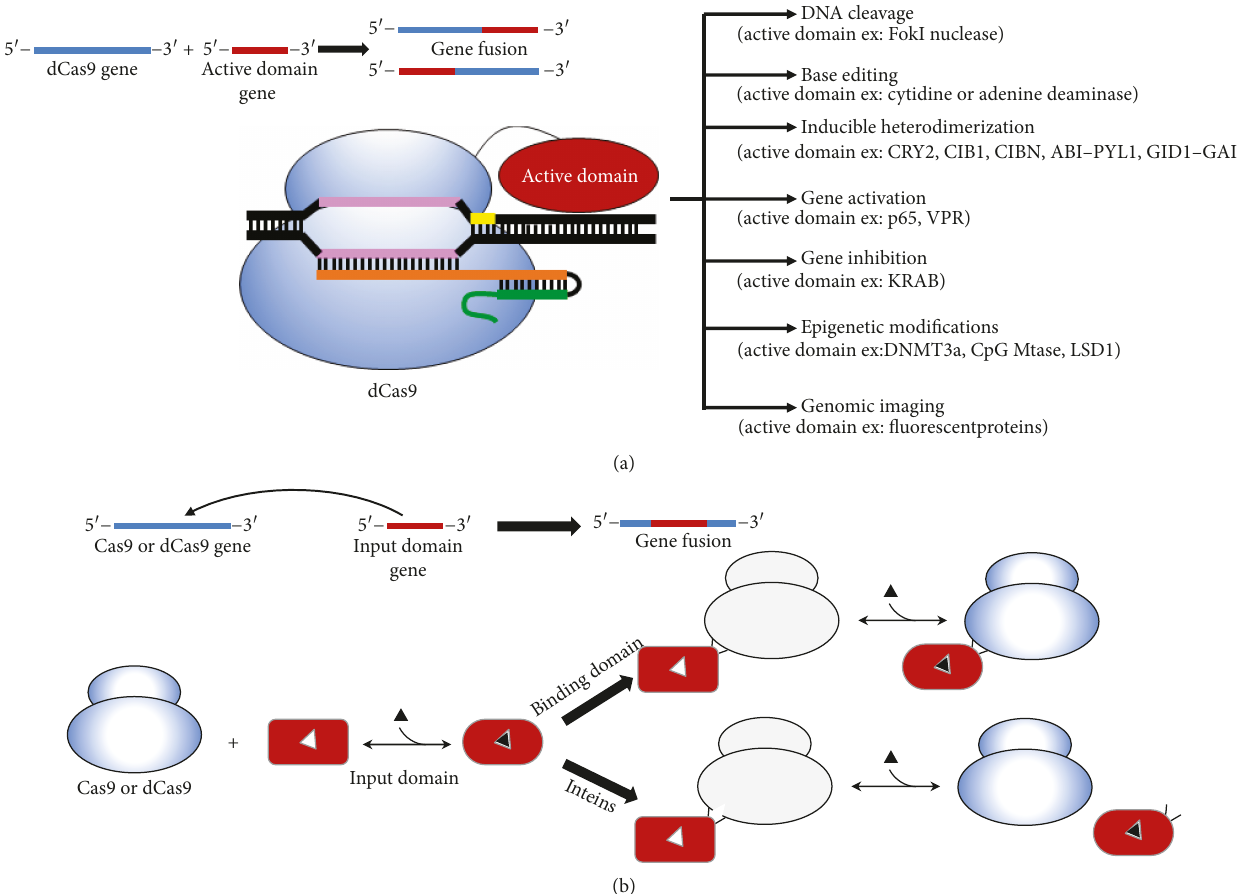
Figure 2: Schematic representations of Cas9 engineering by domain fusion. (a) End-to-end gene fusion approach. A diverse range of new technologies for DNA manipulation can be created by end-to-end fusion of Cas9 with an active domain. These fusions have been used to expand Cas9 applications. (b) Schematic depiction of Cas9 engineering by domain insertion. A switch behaviour could emerge in such a way that the Cas9 protein could be regulated by the input domain ’ s recognition of an input signal. Either binding domains or inteins have been used to generate Cas9 with a switch response. DNA sequences are depicted as lines. A light gray color of the Cas9 indicates that the protein is inactive or less active while blue represents the active state. The signal that modulates the switch is showed as a black